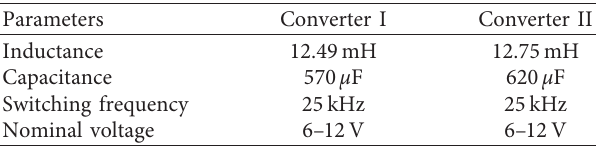
Figure 1: Schematic diagram of a standalone PV system with storage in the middle. Table 1: Parameters for the simulated and experimental modules of the two parallel-connected boost